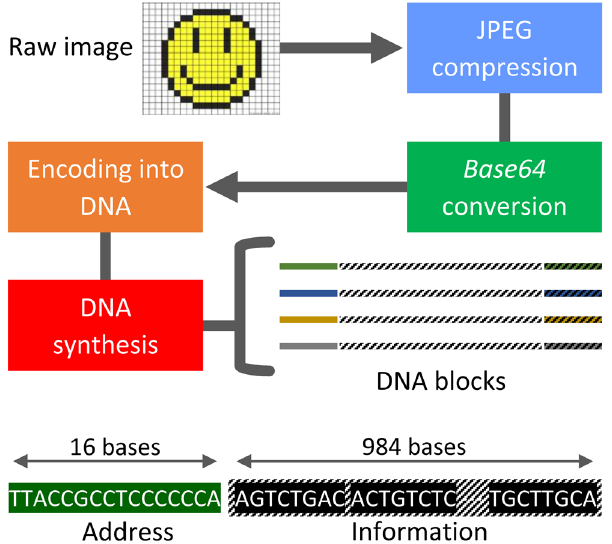
Figure 1. The encoding stage. This stage involves compression, representation conversion, encoding into DNA, and subsequent synthesis. Each synthesized DNA codeword is equipped with one or two addresses. The encoding phase entails constrained coding, which limits the occurrence of the address block to one predefined position in the codeword only, and GC-content balancing of each substring of eight bases. Additional homopolymer checks are added directly into the string or stored on classical media; they correspond to only 0.02% of the data